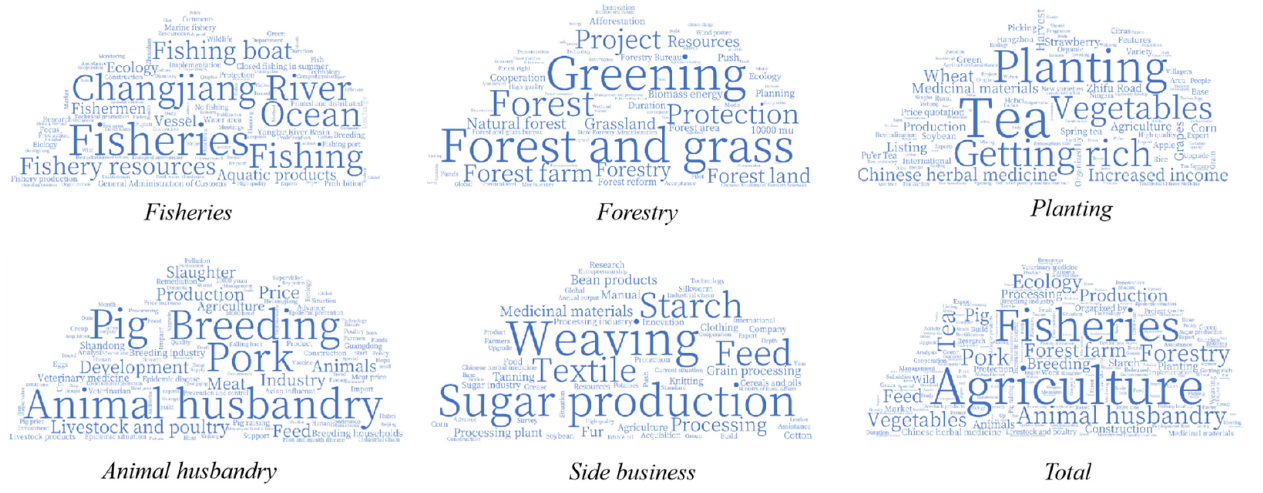
Figure 12. Word clouds for the fisheries, forestry, planting, animal husbandry, and side business categories, along with total words in the constructed data set.